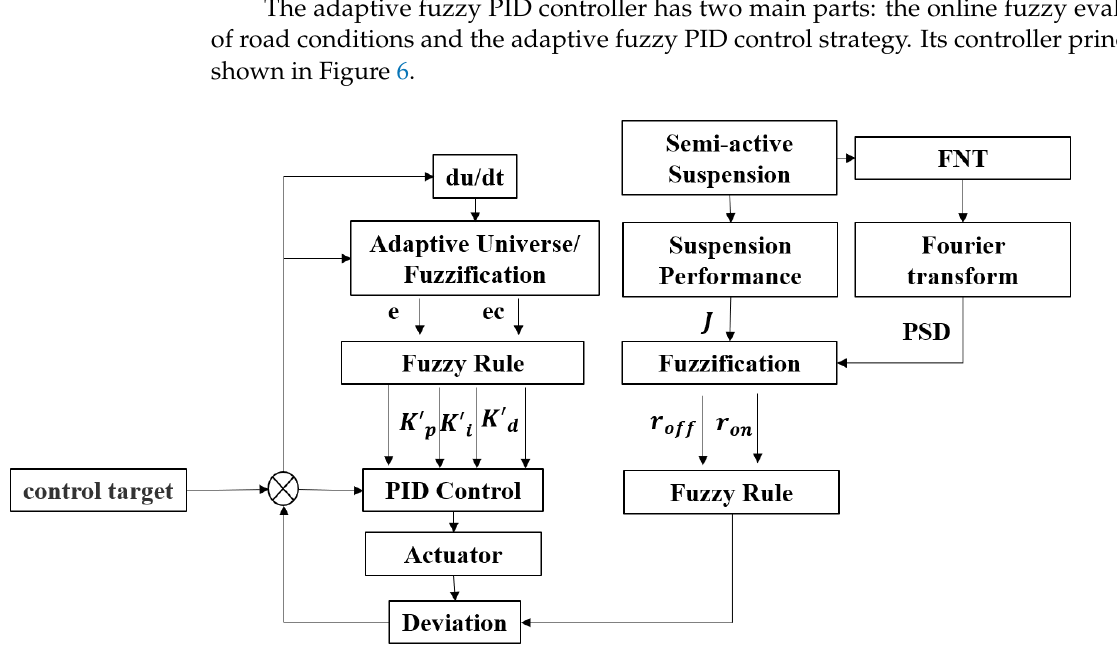
Figure 6. Controller principle